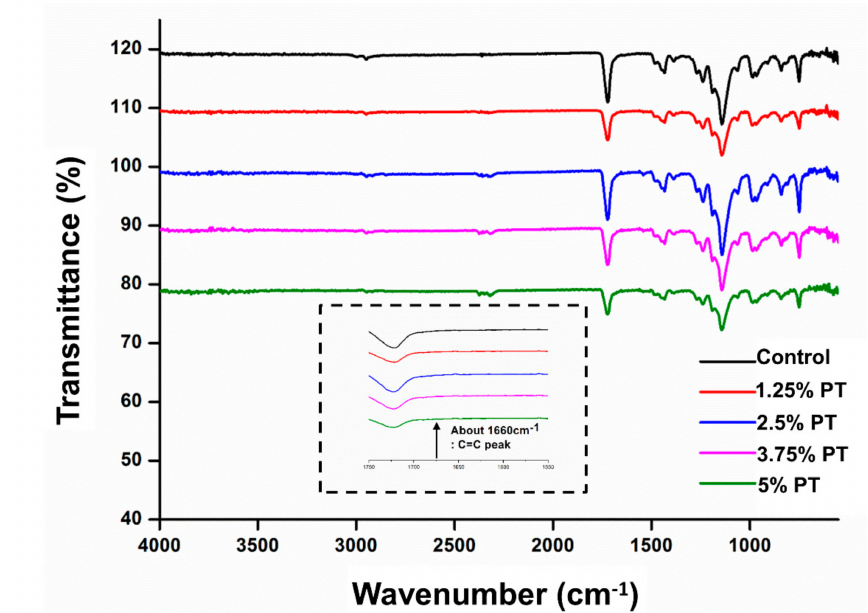
Figure 1. Chemical characterization of poly (methyl methacrylate) (PMMA)-based materials. Fourier transform infrared (FTIR) spectra of control, 1.25% PT, 2.5% PT, 3.75% PT and 5%